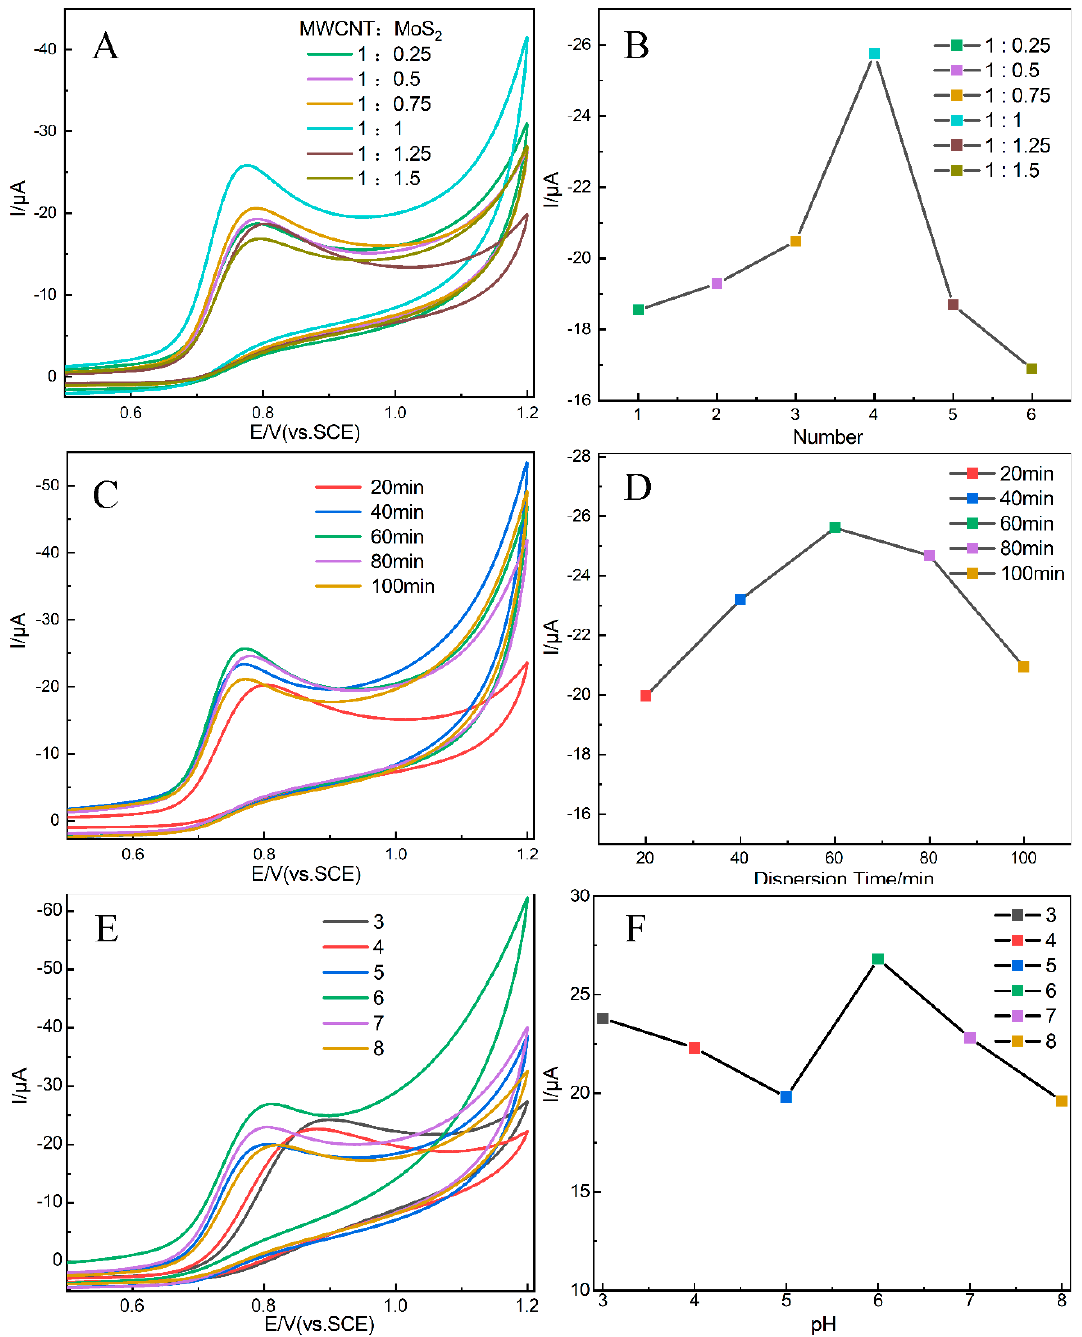
Figure 5. CV curves in 0.1 M PBS with 500 μ M nitrite and peak current graphs: ( A , B ) different mix radios of MWCNT-COOH and MoS 2 , ( C , D ) different dispersion time of MWCNT-COOH/MoS 2 , ( E , F ) detection under different pH values.